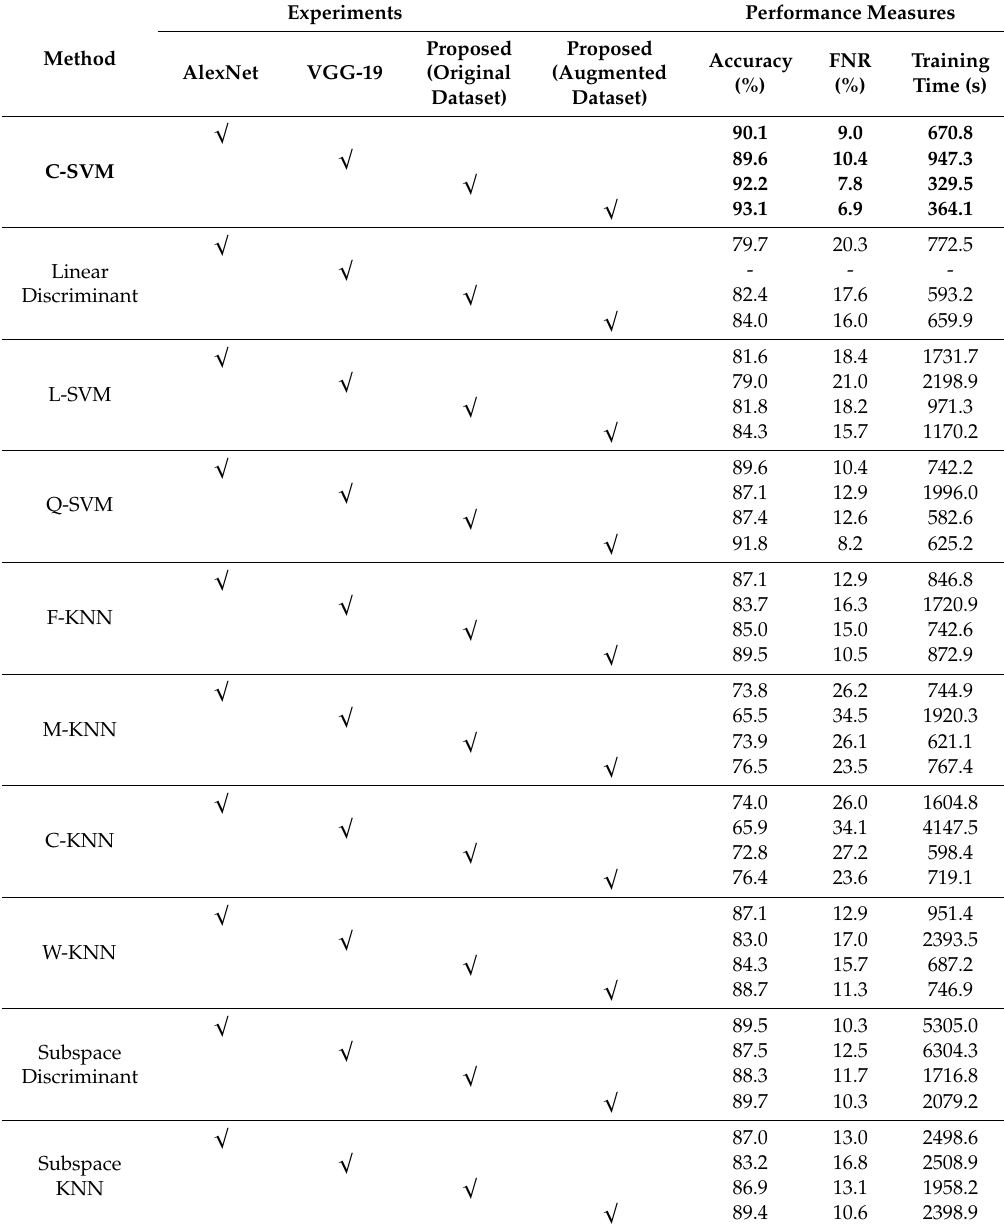
Table 3. Comparison of classification accuracy, false-negative rate (FNR), and Training Time on Tobacco3482 Dataset. Best values are shown in